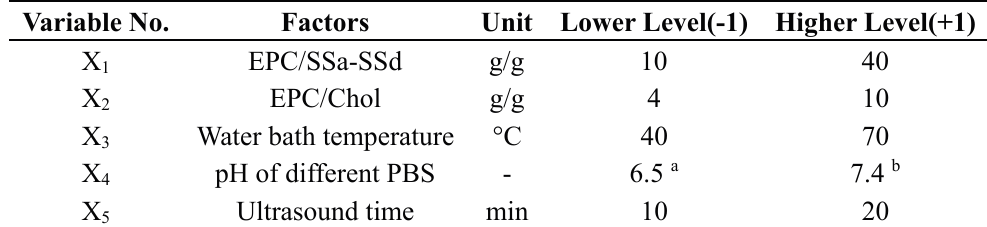
Table 2. Process factors and their two levels used in the Plackett-Burman design. Variable No.